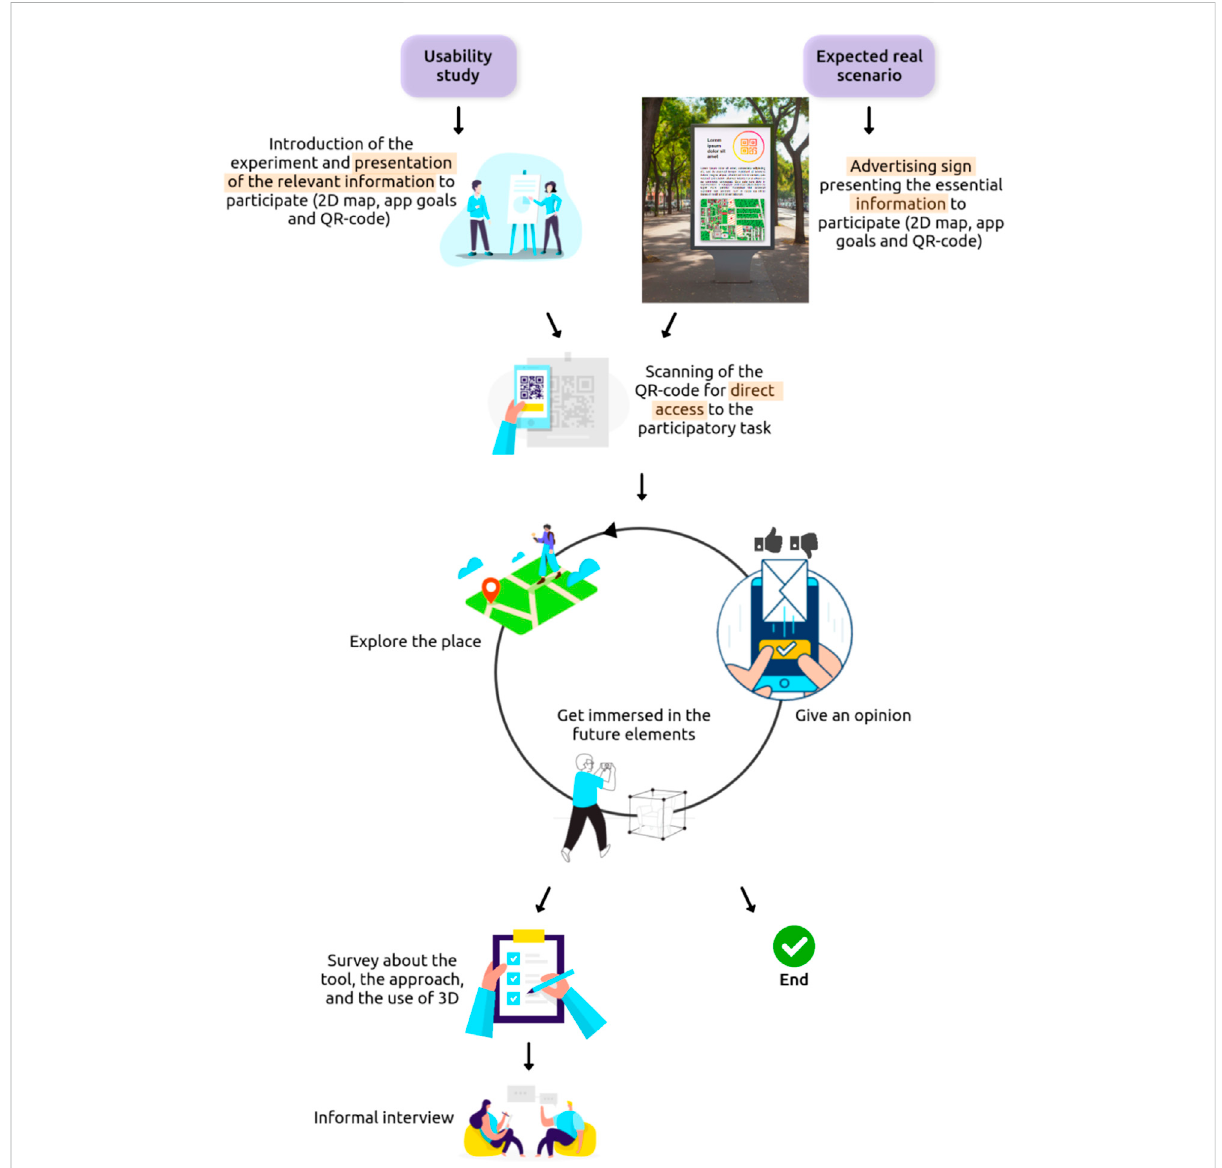
FIGURE 4 The procedure of the usability study. The left track shows the step of the experiments between a facilitator/observer and the participants. The right track portrays the expected practice of the approach/prototype.